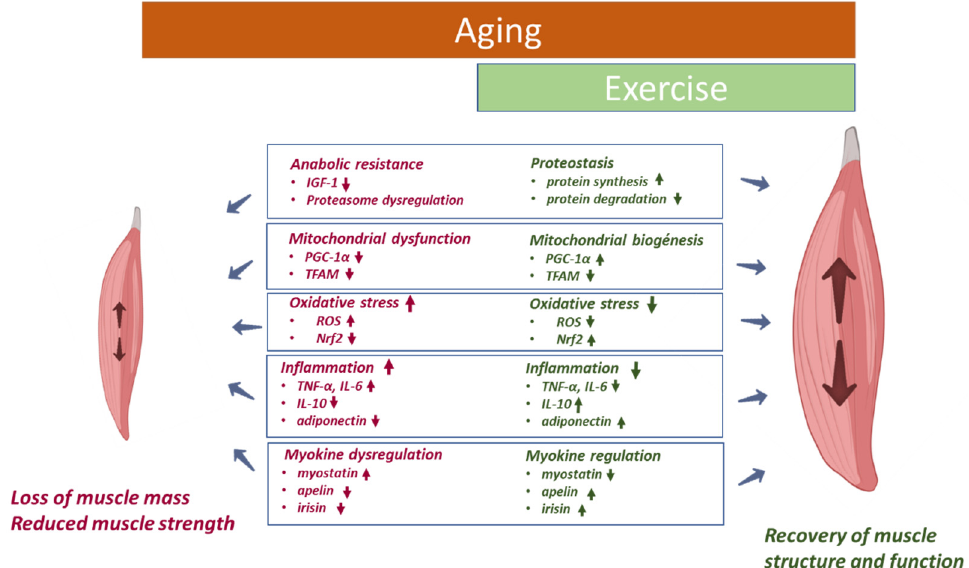
Figure 2. Exercise modulates different signaling pathways affected by aging in skeletal muscle. Aging is associated with muscle mass loss and a reduction in muscle strength resulting from inefficient pathway of anabolic resistance (characterized by decreased insulin-like growth factor (IGF-1) and proteasome dysregulation and mitochondrial dysfunction, specifically reduced expression of factor peroxisome proliferator-activated receptor γ coactivator-1 α (PGC-1 α ) and transcription factor A mi- tochondrial (TFAM). In addition, increased oxidative stress resulting from the imbalance of increased reactive oxygen species, ROS, and reduced nuclear erythroid-2 like factor-2 (Nrf2), increased chronic low-grade inflammation (increased proinflammatory cytokines and decreased anti-inflammatory cytokines), jointly with myokine dysregulation play a key role in muscle alteration observed with aging. Exercising results in improved proteostasis regulation where protein synthesis increased while protein degradation is reduced. On the other hand, exercise increased mitochondrial biogenesis, reduced age-related oxidative damage, diminished chronic inflammation, and improved myokine profile, which consequently improves muscle structure and